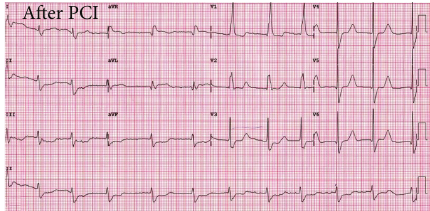
Figure 2: ECG after procedure demonstrated atrial fibrillation with complete right bundle branch block without Q wave